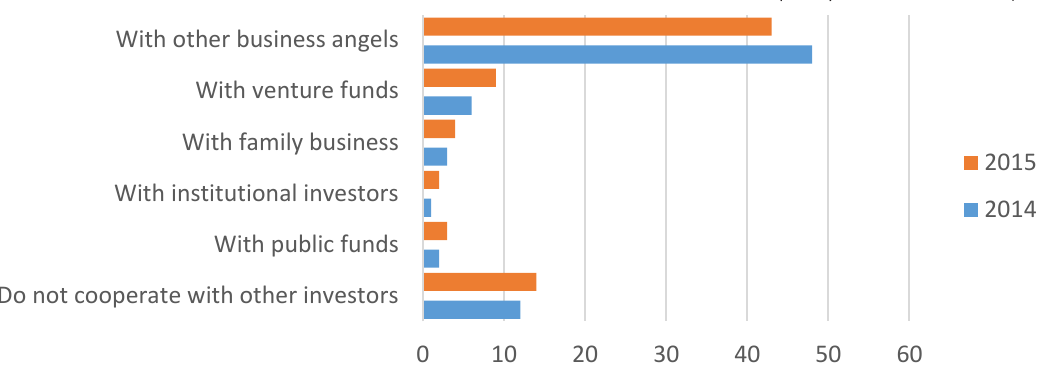
0 Figure 4. Statistics of project co-investment by EU business angels in 2014–2015 (percentage of the total number of business angels), %